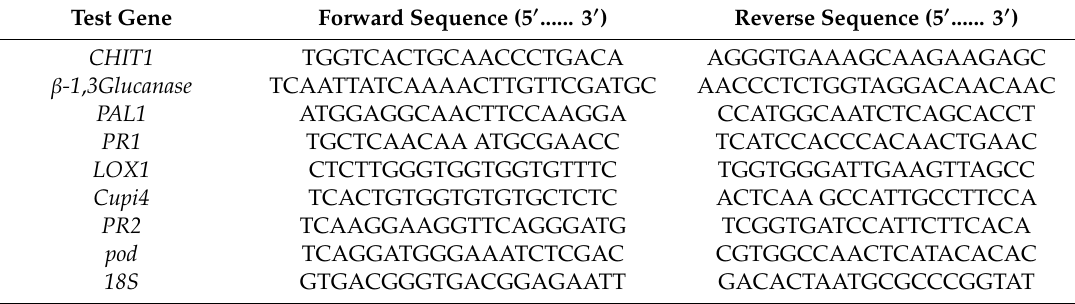
Table A1. Primers of all test genes JA, SA, and ET involved in plant defense.